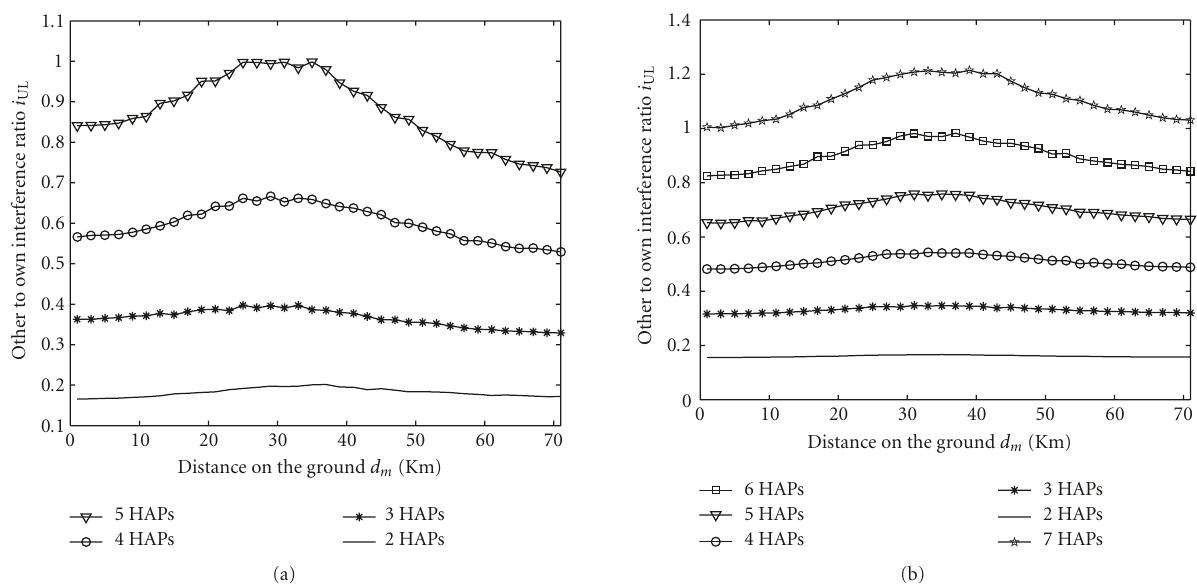
60 . 50 . 40 . 30 . 20 . 10 . 00 .